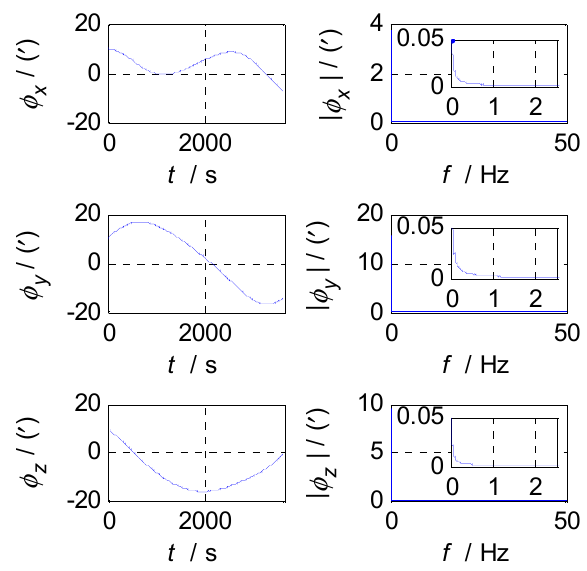
Figure 4. Attitude errors and frequency characteristics of SINS.